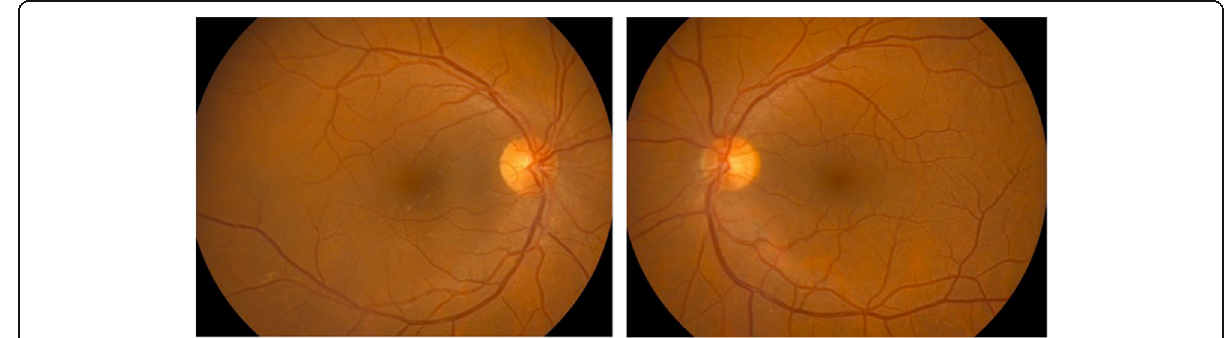
Fig. 4 Retinographies performed after 16 weeks of dabrafenib treatment showing complete resolution of vitreous opacities in the right eye